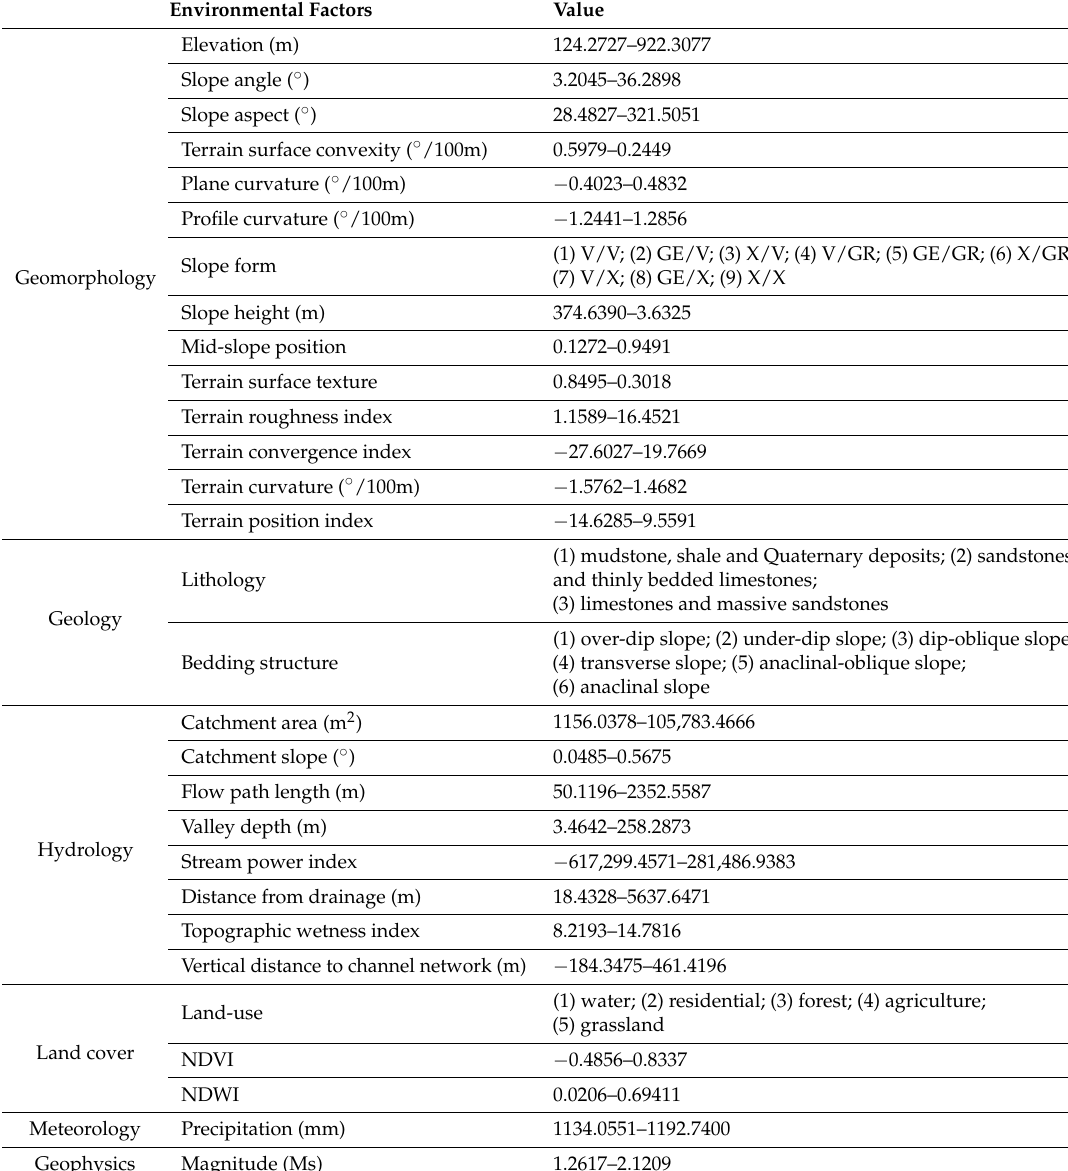
Table 4. Landslide environmental factors and their respective